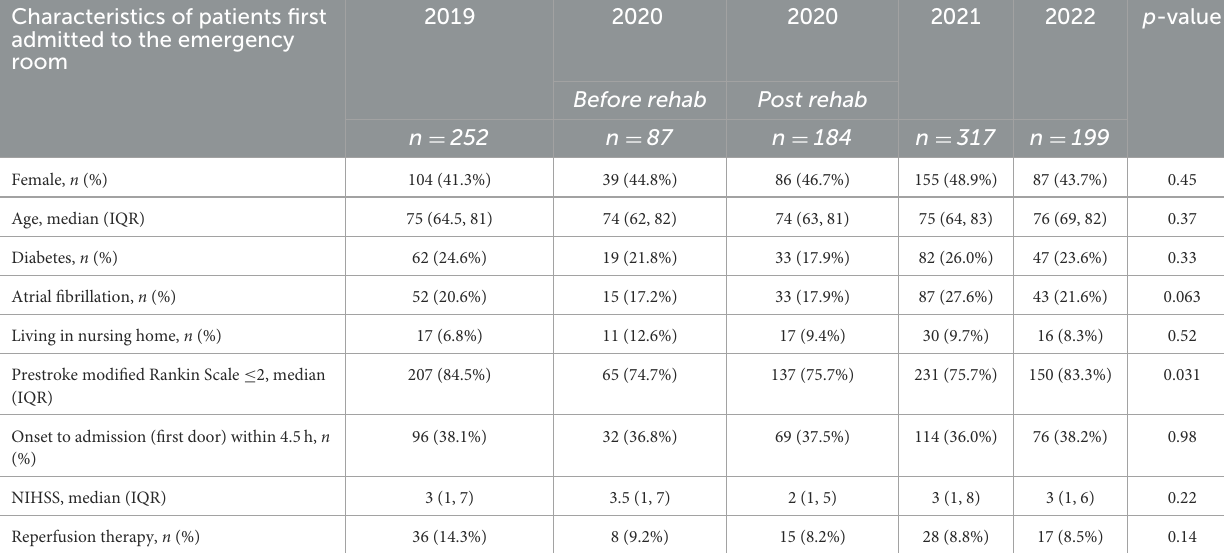
TABLE 4 Characteristics of patients first admitted to the emergency room stratified by year. Characteristics of patients first admitted to the emergency